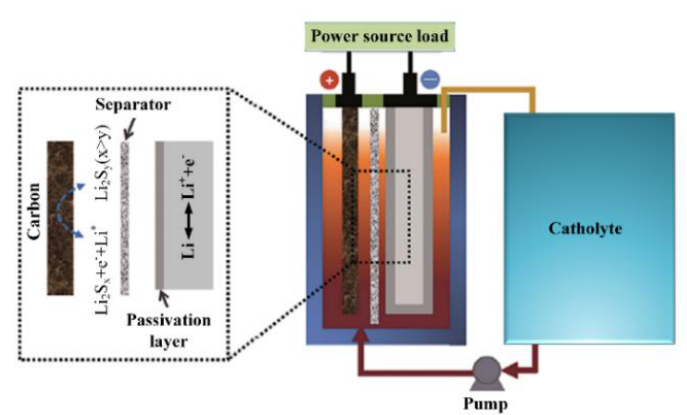
Figure 55. Schematic diagram of the Li-Ps semi solid flow cell; Li-Ps electrolyte is used, which is pumped through the core, while a microporous separator is used to separate Li electrode and the catholyte [165].